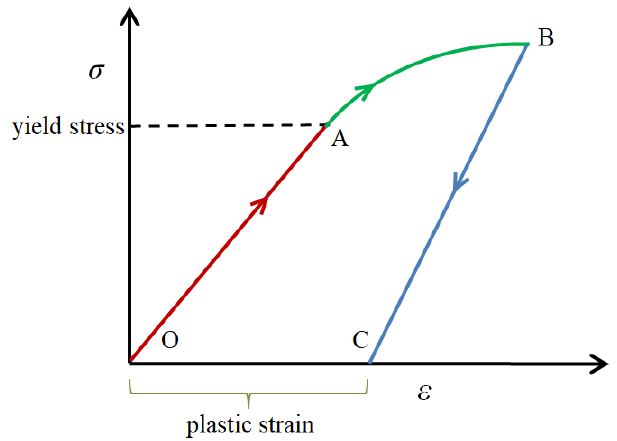
Figure 7. Non-linearity of distributed optical fiber.